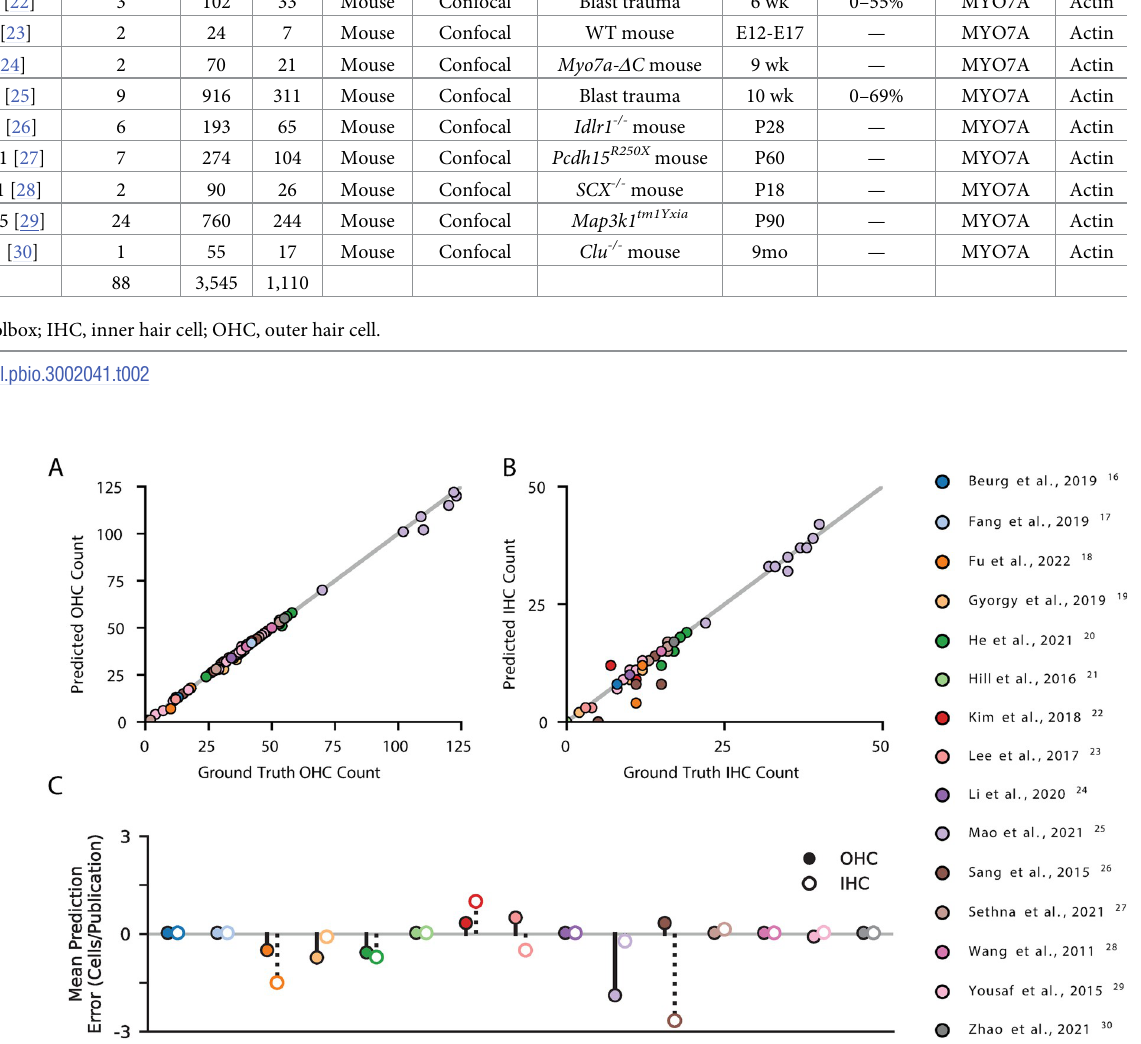
Fig 5. HCAT detection performance on published images of cochlear hair cells. HCAT detection performance was assessed by running a cell detection analysis in the GUI on 88 confocal images of cochlear hair cells sampled from published figures across 15 different original studies [16–30].None of the images from this analysis were used to train the model. Each image was adjusted within the GUI for optimal detection performance. Cells in each image were also manually counted (presented as ground truth values) and results compared to HCAT’s automated detection. The resulting population distributions of hair cells are compared for OHCs ( A ), and IHCs ( B ). The mean difference in predicted number of IHCs (open circles) and OHCs (filled circles) in each publication is summarized for each cell type: zero indicates an accurate detection, negative values indicate false negative detections, while positive values indicate false positive detections ( C ). GUI, graphical user interface; HCAT, hair cell analysis toolbox; IHC, inner hair cell; OHC, outer hair cell.